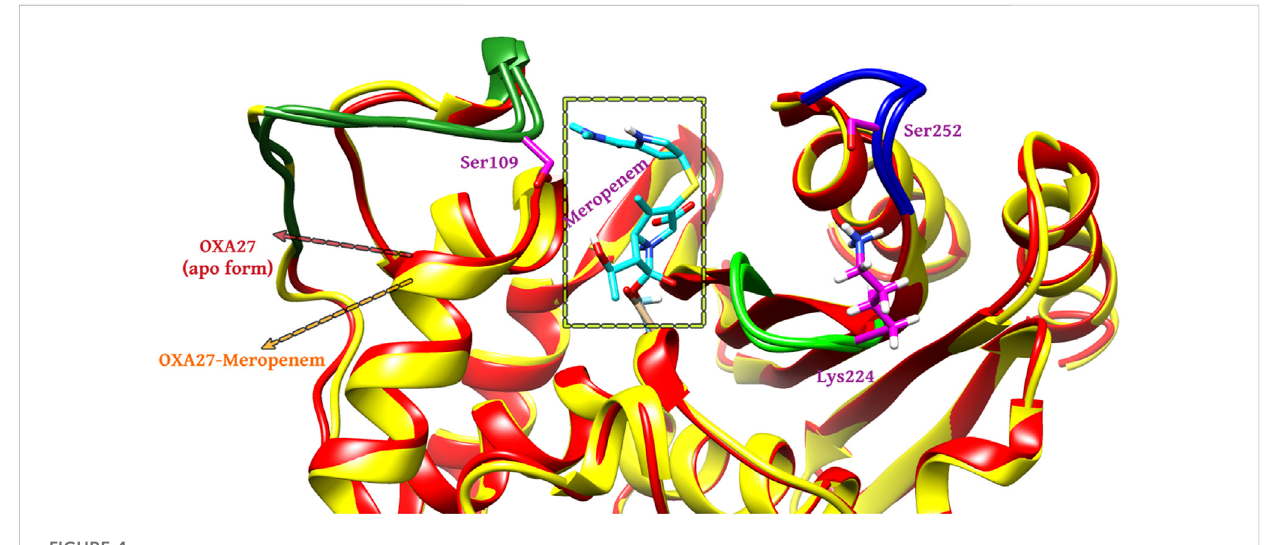
FIGURE 4 Molecular dynamics simulation analysis for the (A) apo form (red color) and (B) presence of meropenem (yellow color).